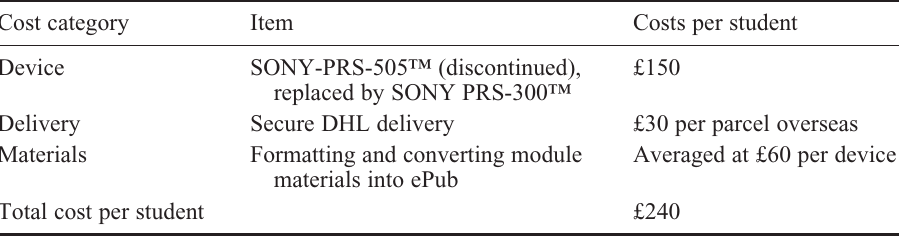
Table 6. Cost of introducing e-book readers in